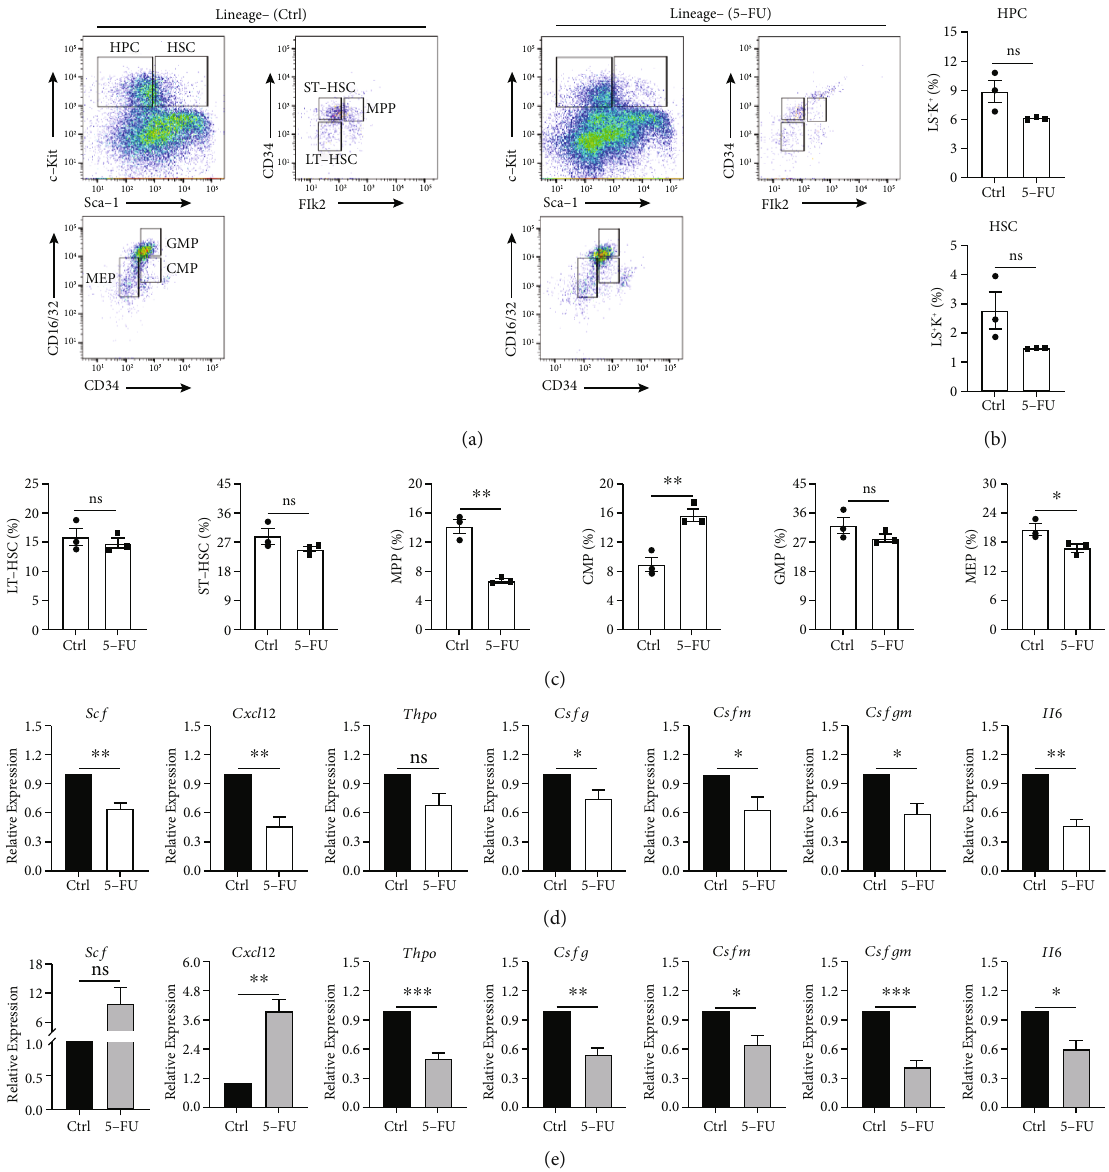
Figure 2: 5-FU impairs the hematopoietic regulatory ability of BA-MSCs. (a) Flow cytometric plots of BMCs cocultured with DMSO- treated BA-MSCs and 5-FU-treated BA-MSCs for 2 days. Flow cytometric plots are gated on lineage-negative BMCs and showing cell subsets of HPC (Lin - Sca-1 - c-Kit + ), HSC (Lin - Sca-1 + c-Kit + ), LT-HSC (Lin - Sca-1 + c-Kit + CD34 low Flk2 low ), ST-HSC (Lin - Sca-1 + c- Kit + CD34 + Flk2 low ), MPP (Lin - Sca-1 + c-Kit + CD34 + Flk2 + ), CMP (Lin - Sca-1 - c-Kit + CD34 + CD16/32 low ), GMP (Lin - Sca-1 - c-Kit + CD34 + CD16/ 32 + ), and MEP (Lin - Sca-1 - c-Kit + CD34 low CD16/32 low ) ( n = 3 ). (b, c) Flow cytometry analysis of the percentage of HPC, HSC, LT-HSC, ST-HSC, MPP, CMP, GMP, and MEP in the BMCs cocultured with DMSO-treated BA-MSCs and 5-FU-treated BA-MSCs for 2 days were detected by qRT-PCR ( n = 5 ). (e) Gene expressions of Scf , Cxcl12 , Thpo , Csfg , Csfm , Csfgm , and Il6 in control mice and